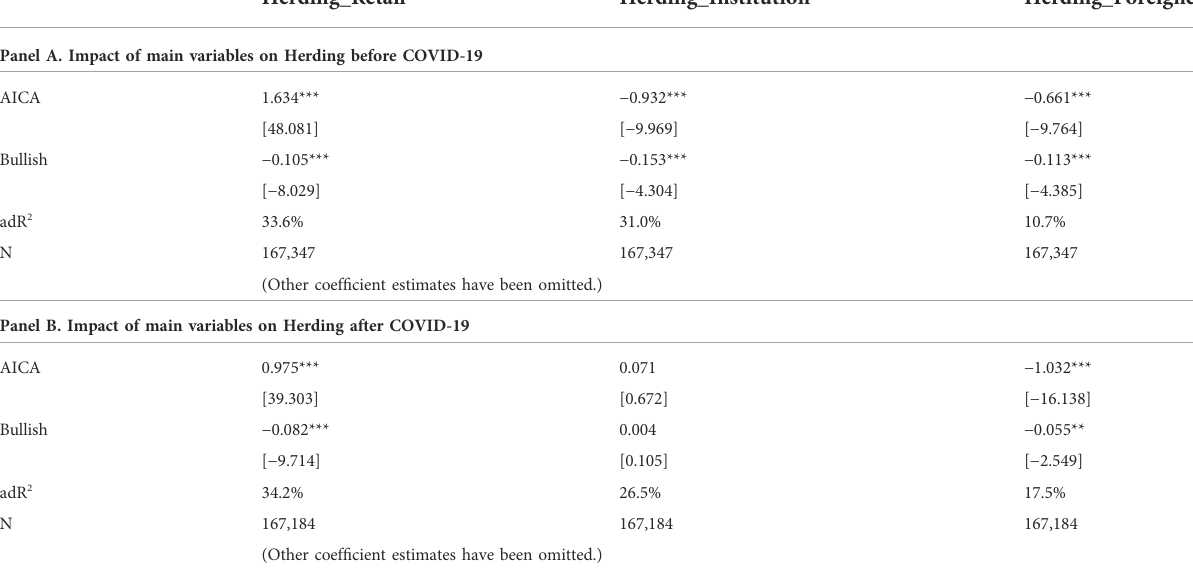
TABLE 4 Impact of COVID-19 on the association between AICA, Bullish and Herding. Table reports impact of COVID-19 on the association between AICA, Bullish and investor ’ s Herding. Regression analysis is performed by dividing COVID-19 into before and after with 22 March 2020 as the reference date and this table represents regression results using Eq. 6. AICA is the abnormal ICA. Bullish is an investment sentiment indicator that represents the opinion score. For brevity, We only show the results of the main variables in the table and the coef fi cient estimates of controlled variables are suppressed.